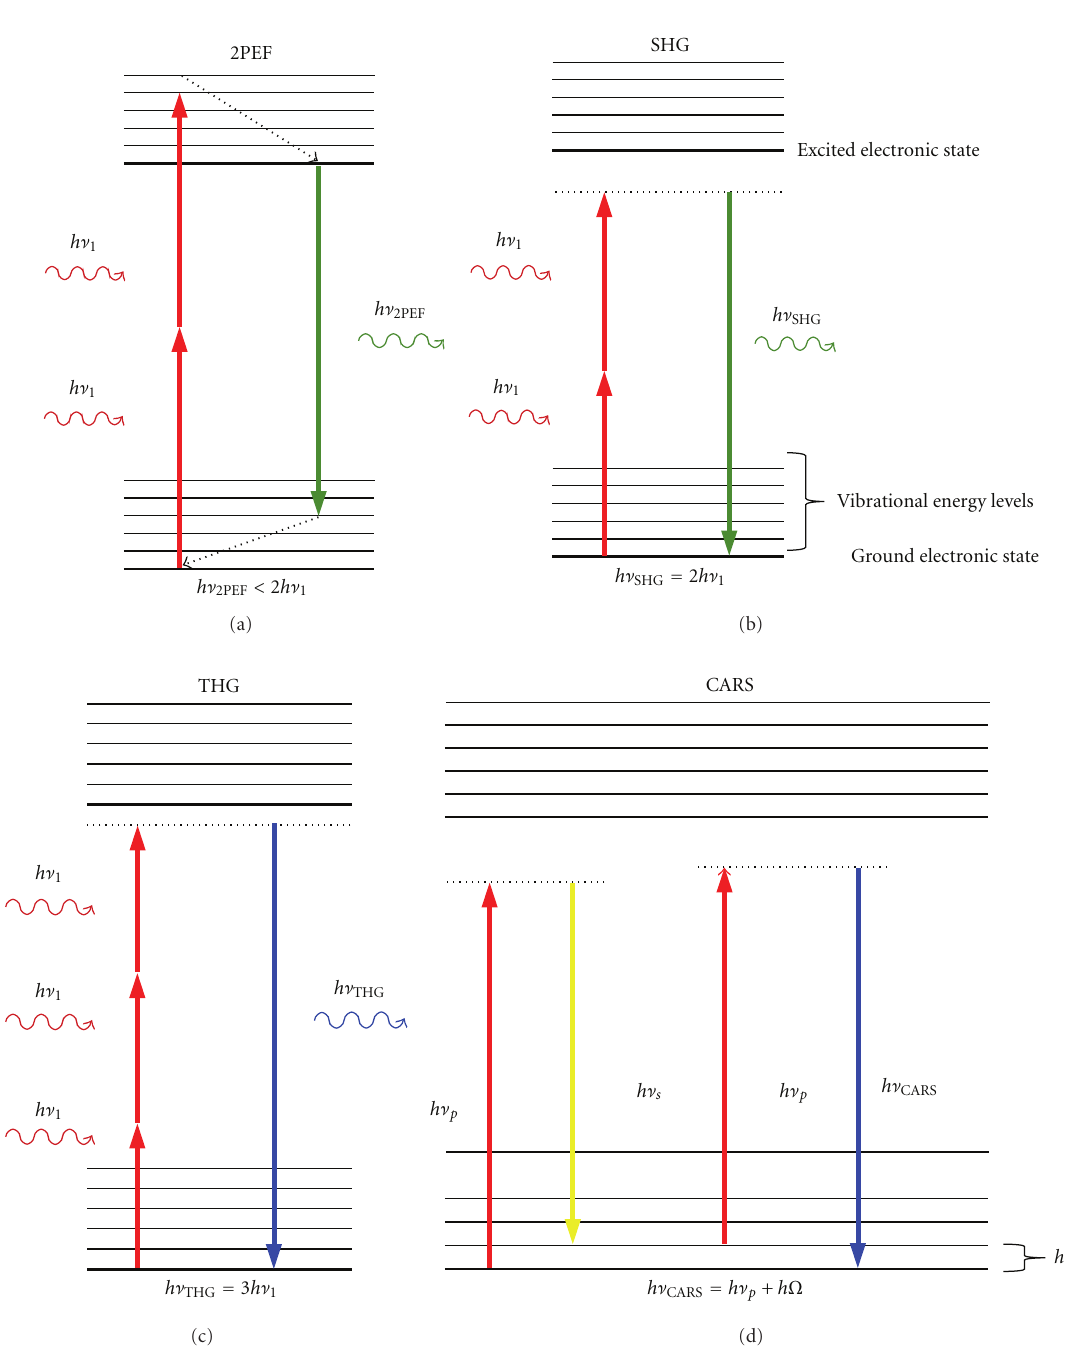
Figure 1: Jablonski diagram showing the interaction of multiple infrared photons with the electronic and vibrational energy levels of a molecule. (a) In two-photon excitation fluorescence (2PEF), the molecule absorbs two infrared photons that promote it to the excited electronic state. After relaxation to a lower vibrational level, the molecule emits a lower energy (red-shifted) photon. (b) In second harmonic generation (SHG), two infrared photons are instantaneously upconverted to a single photon of twice the energy. (c) In third harmonic generation (THG), three infrared photons are instantaneously upconverted to a single photon of thrice the energy. (d) In Coherent anti- Stokes Raman Scattering (CARS), two photons with energies h ν p and h ν s coherently excite the vibrational level with energy h Ω = h ν p − h ν s . An additional photon, h ν p , interacts with the vibrationally excited molecule emitting a photon with energy given by the original incident photon energy plus the vibrational energy, h ν CARS = h ν p + h Ω , leaving the molecule in its original ground state. (Note that photon energy is given by Planck’s constant, h , multiplied by the frequency of the photon ν